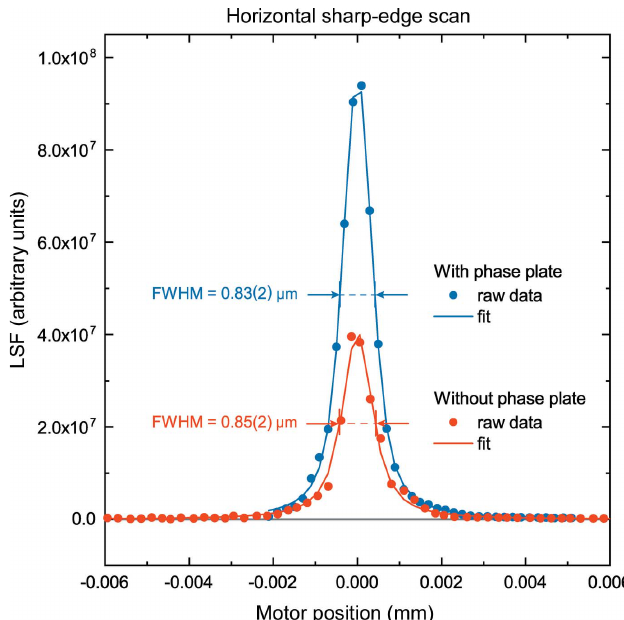
Figure 3 A comparison of the horizontal focal size with (blue data) and without (red data) the correcting phase plate. The curves correspond to the derivative signal of the sharp-edge scans, the linear spread function (LSF). Analysis of the curves confirms the similar size of the X-ray beam in the horizontal direction. Given the same acquisition time per point, the higher values for the blue data indicate higher flux values for the setup when corrected with the phase plate. With the phase plate (blue), one can employ a larger opening of the SLT installed in front of the DCM position. Implementation of the phase plate enables a higher intensity X-ray beam while maintaining a small beam size with similar, or even slightly smaller, beam tails at the focal spot.